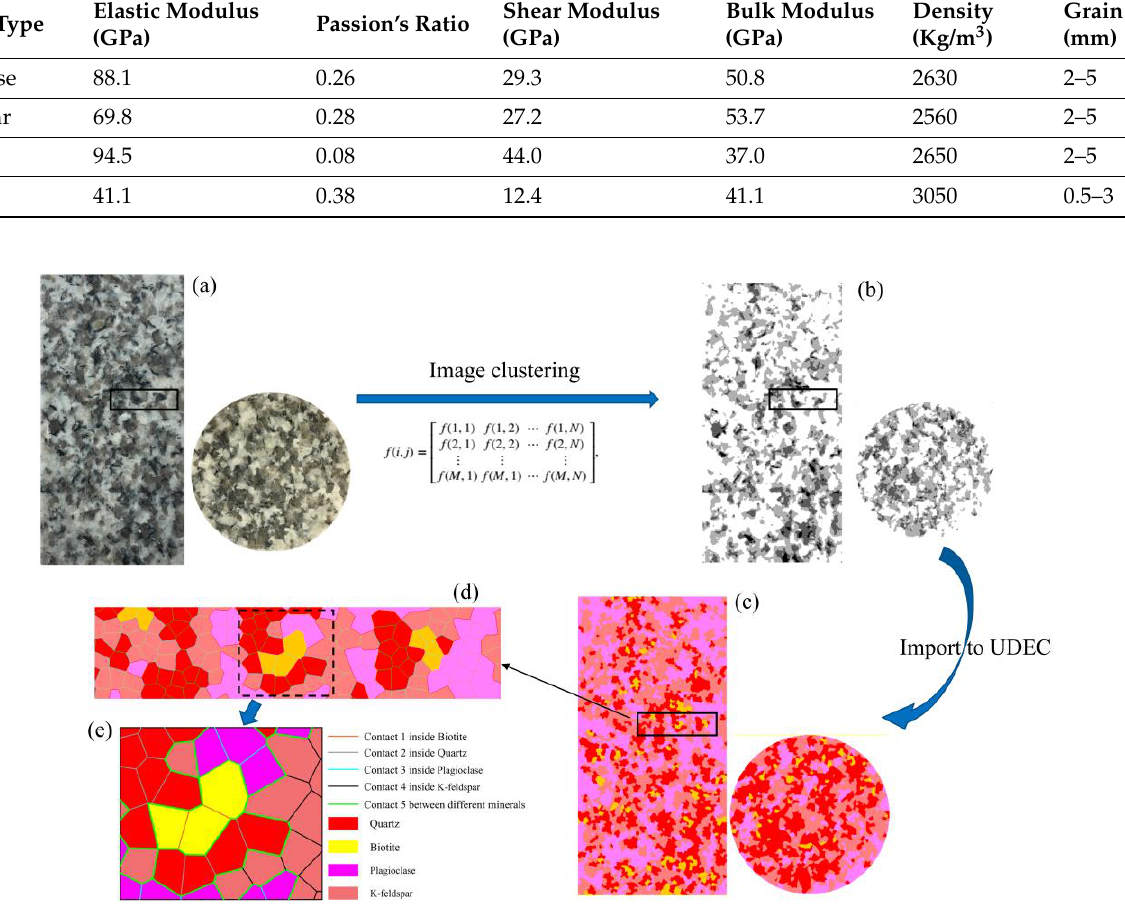
Figure 3. Heterogeneous rock numerical modeling process based on digital image processing. ( a ) Digital images of test samples (Uniaxial/Triaxial and split test samples); ( b ) Cluster image of different crystal components; ( c ) Numerical Modeling of Heterogeneity; ( d ) Partially magnified image; ( e ) Joint connection heterogeneity of different crystal compositions.